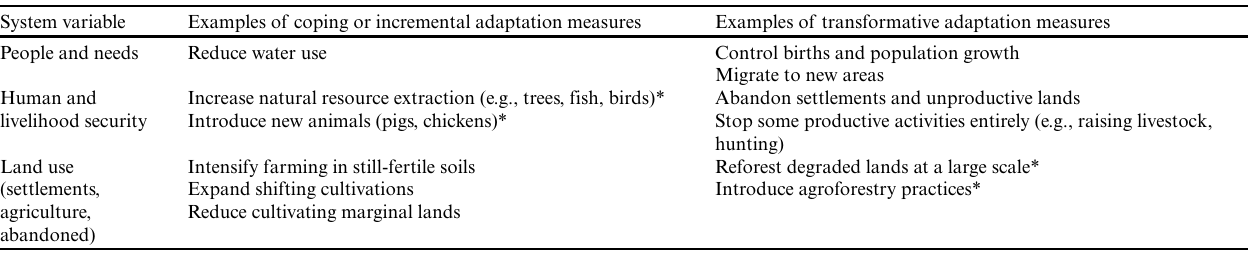
Table 4. Overview of adaptation strategies implemented by societies whose economic activities and well-being were severely affected by climate change (societal collapse). Adaptation strategies are characterized by the type of adaptation measure (coping or incremental, or transformative) and whether they are ecosystem-based adaptation (*).